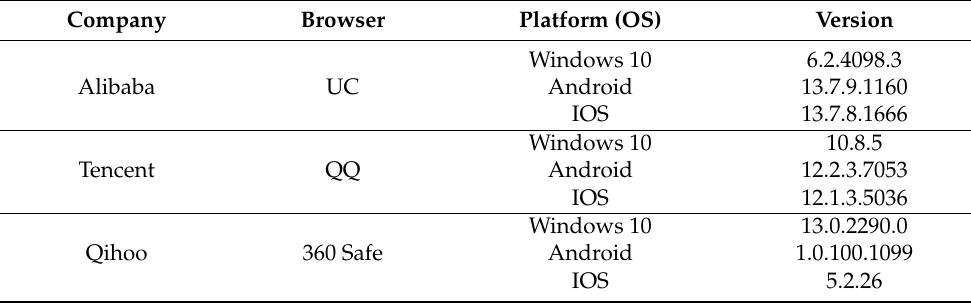
Table 9. Overview of the platforms and versions of browsers.